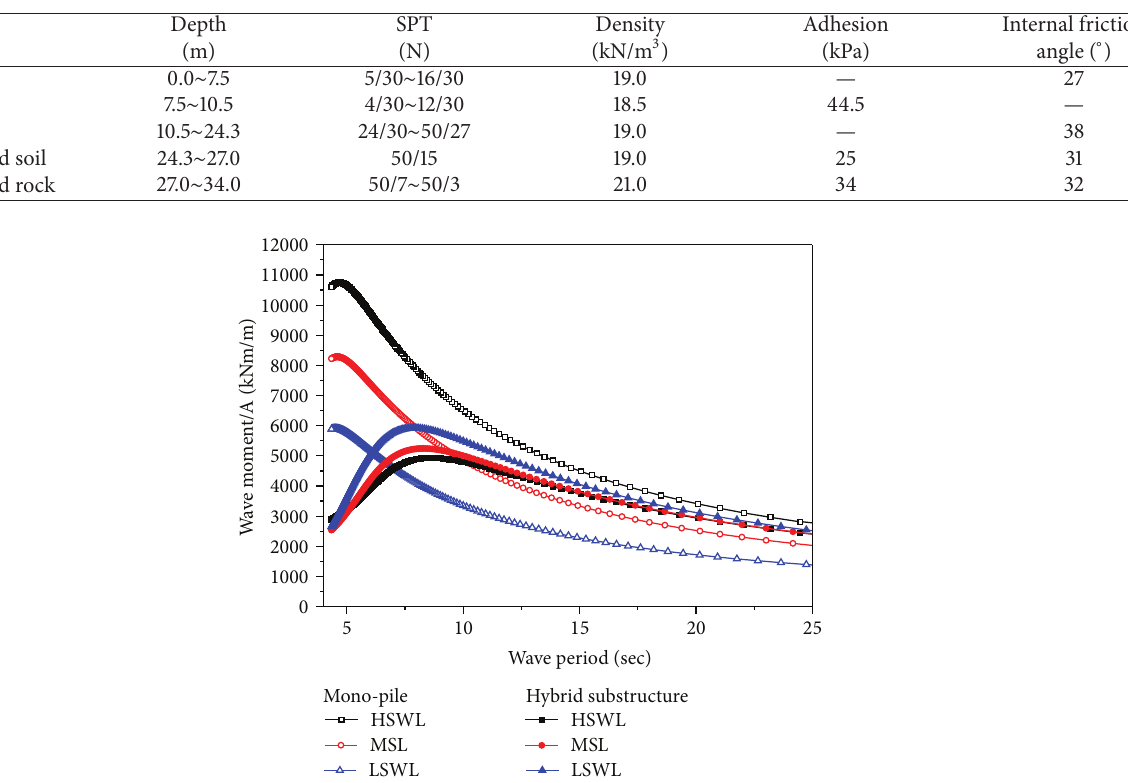
Table 6: Soil conditions.